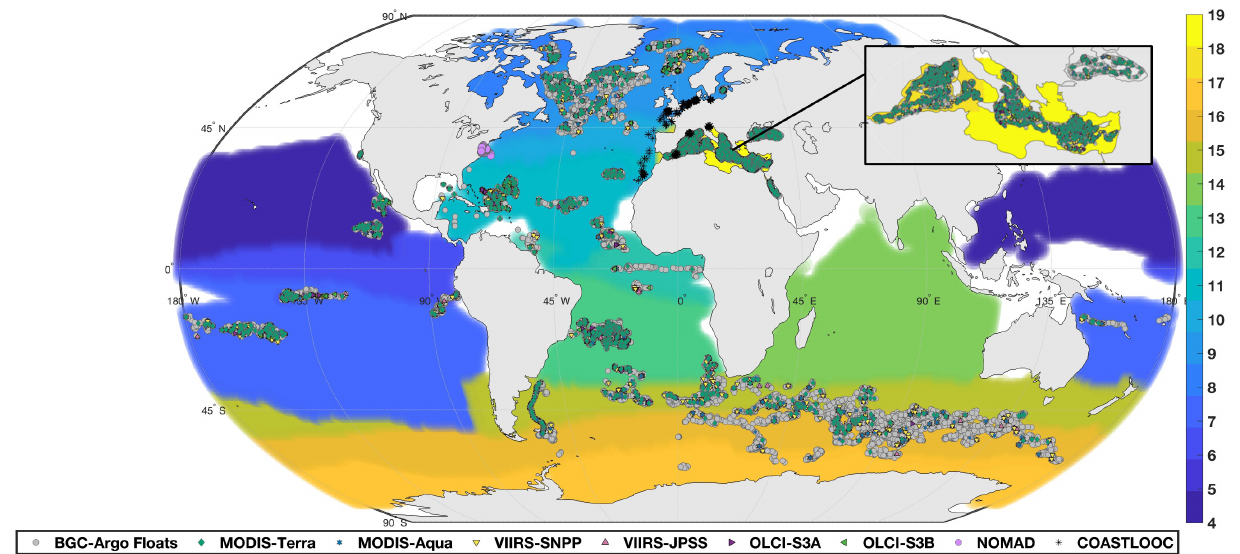
Figure 2. Map of Bio-Argo float observations and in situ observations used for algorithm development colored by matchups with individual satellite sensors or dataset. Background represents oceanic biomes 1–17 of [12]. Insert represent the Mediterranean Sea and the two biomes we added. The names associated with each biome number and color are listed in Table